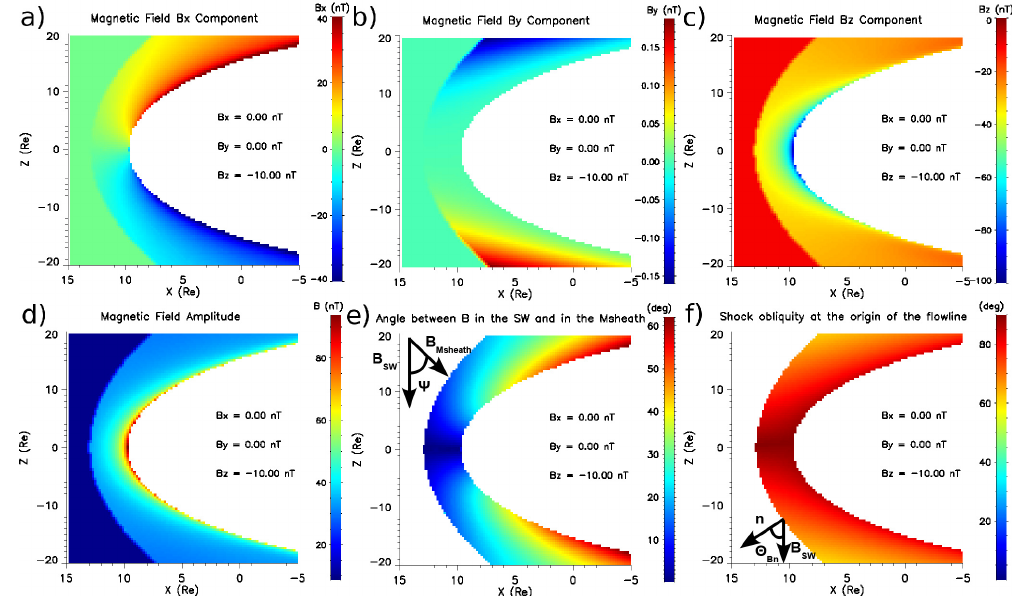
Fig. 4. Results of the model for steady solar wind conditions ( B z = − 10nT, V SW = 400kms − 1 n SW = 5cm − 3 and M A = 4 . 1). The panels correspond to (a) B x , (b) B y , (c) B z , (d) B , (e) ψ , the angle between the magnetic field direction in the solar wind and in the magnetosheath, and (f) 2 Bn , the shock obliquity at the origin of the